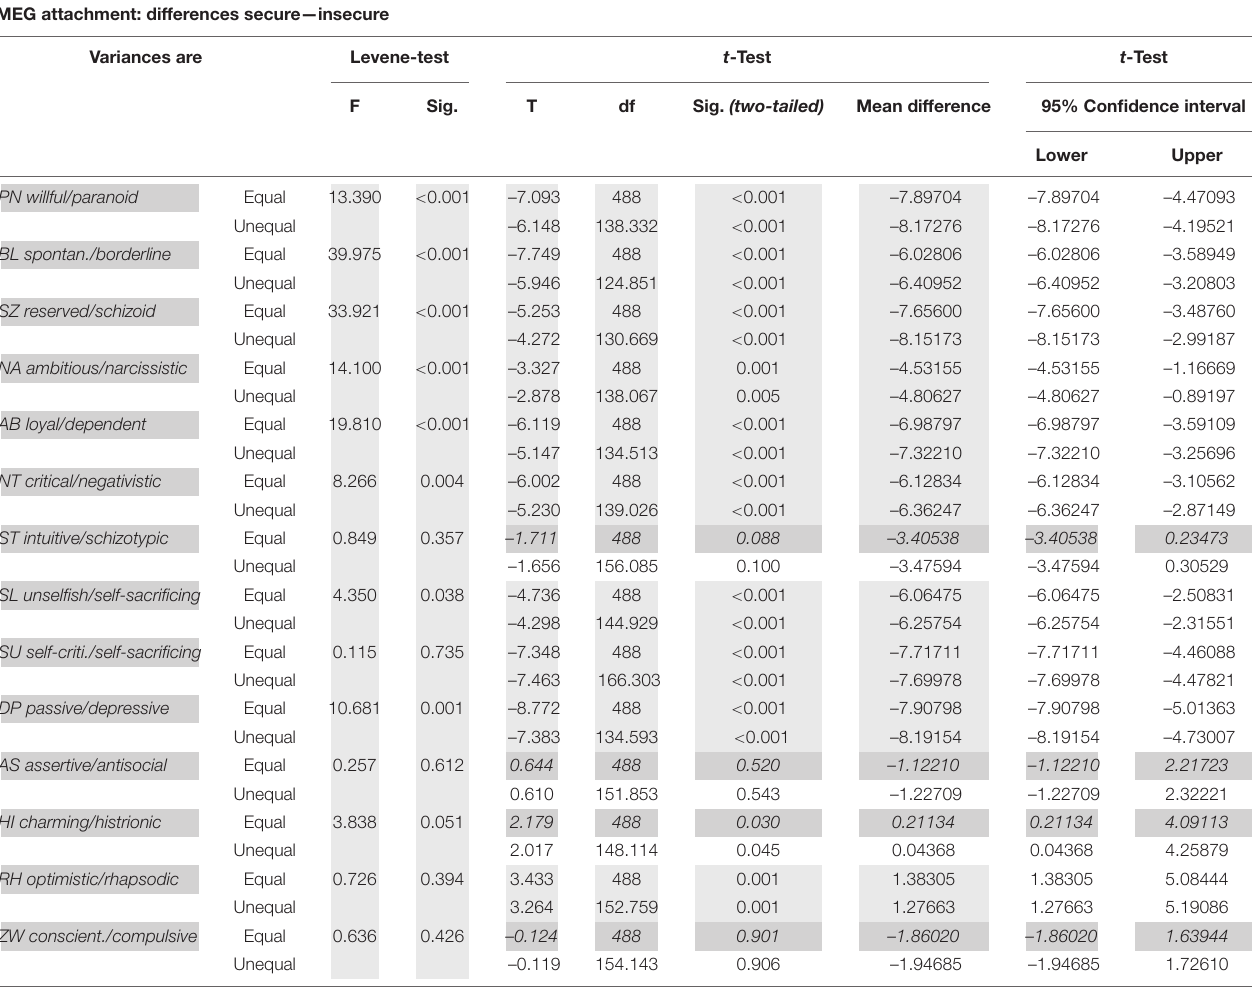
TABLE 3 | Test statistics for the differences between 386 securely and 104 insecurely attached HYP MEG participants in 14 personality styles of the PSDI. MEG attachment: differences secure—insecure Variances